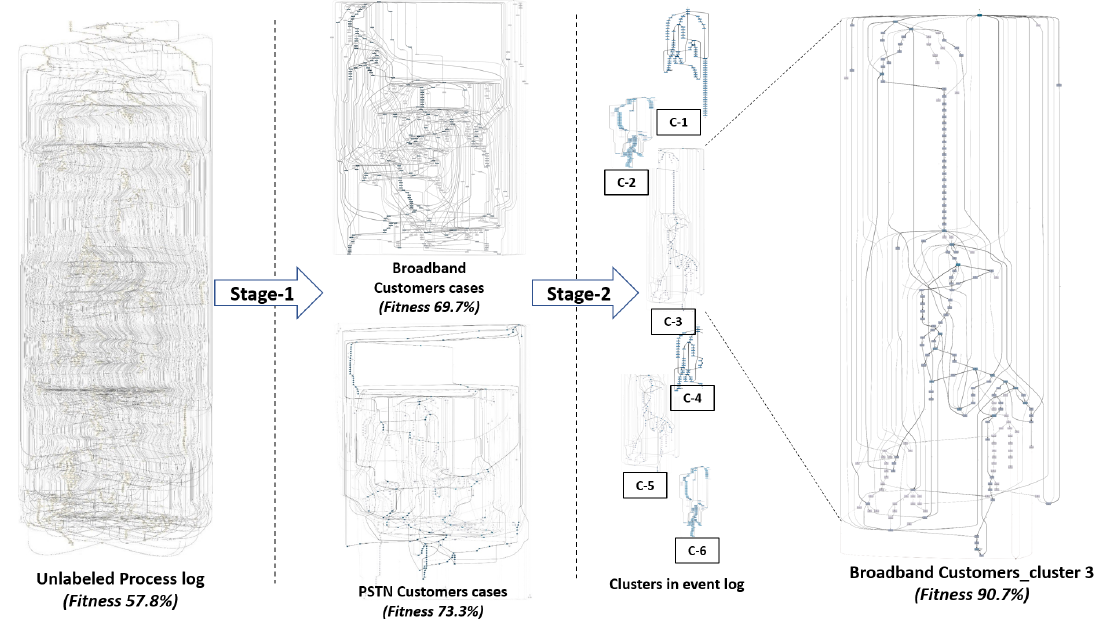
Figure 17. Impact of model fitness at each stage of the